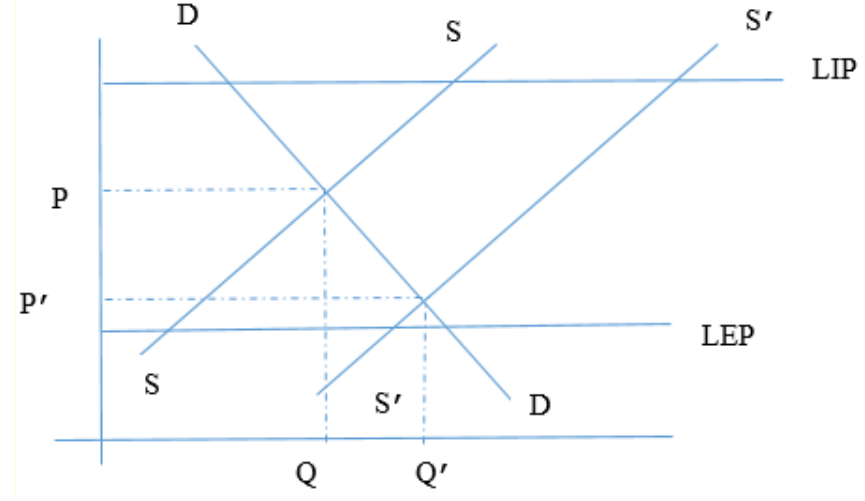
Figure 1. High transfer costs and an autarky economy for the local market.